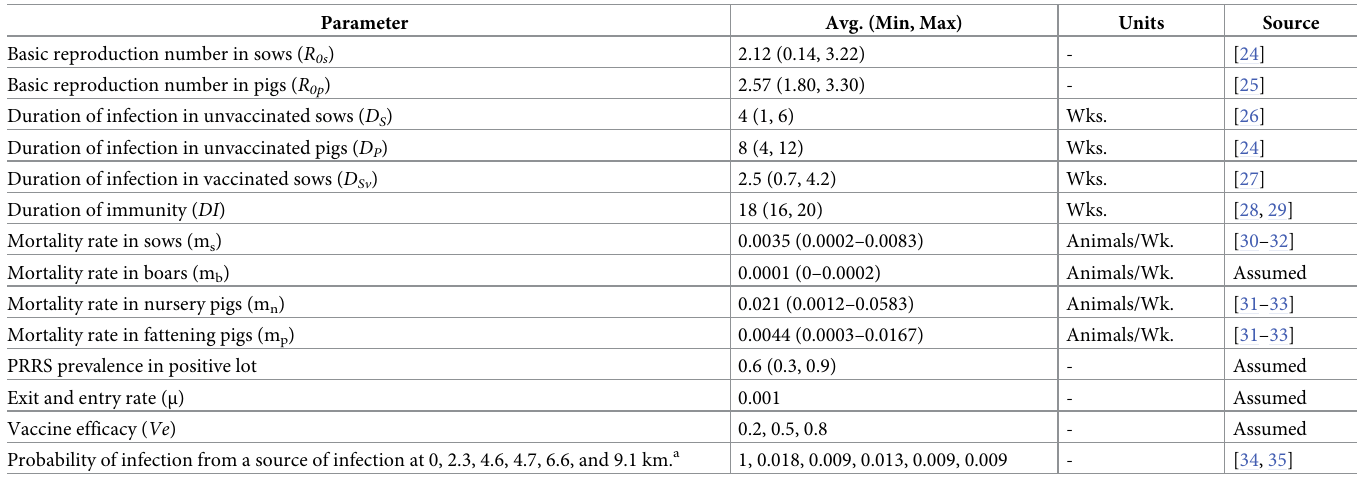
Table 2. Parameters used in the